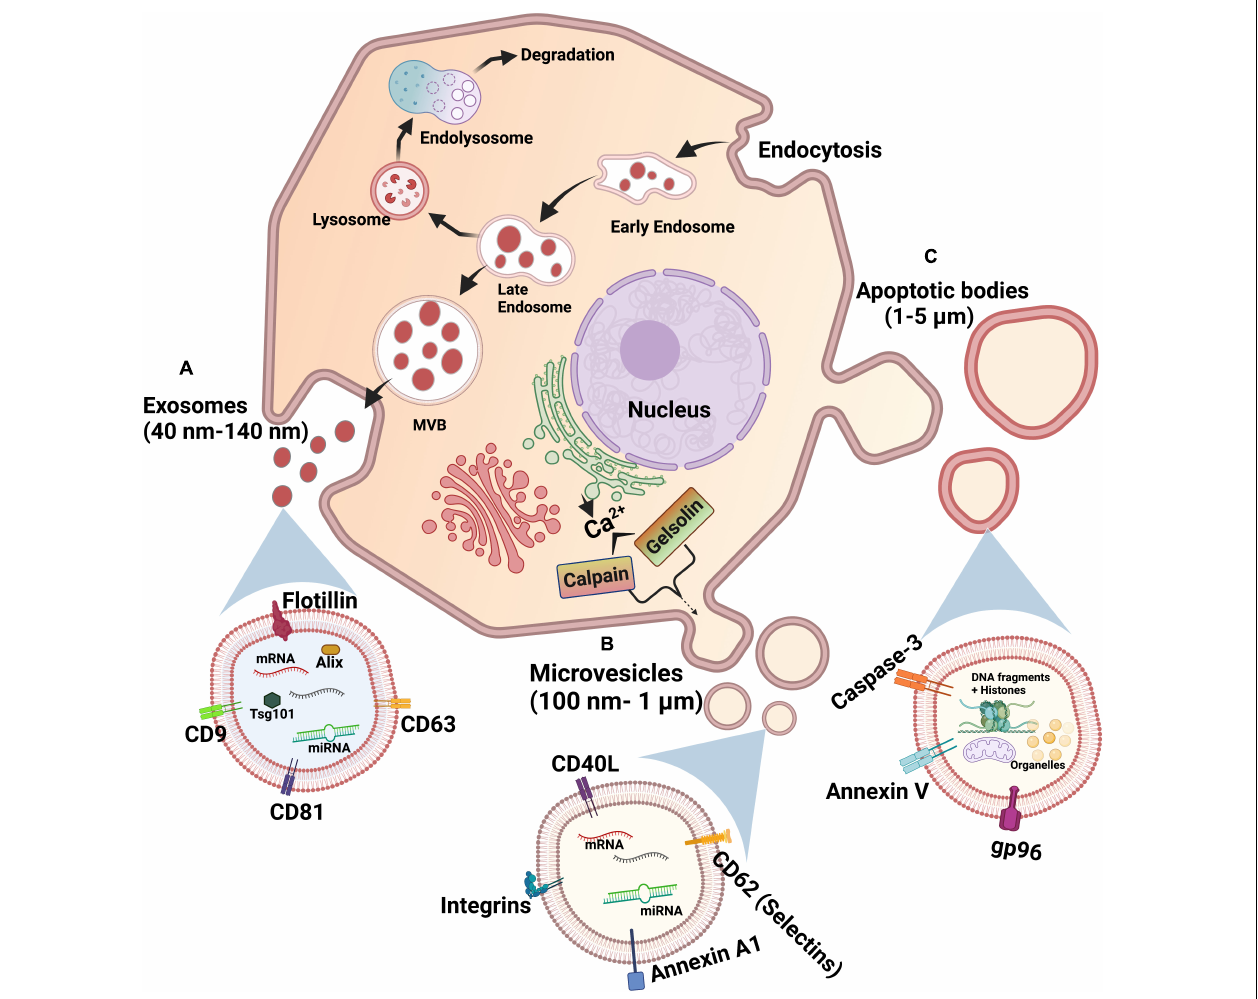
FIGURE 1 | Biogenesis of extracellular vesicles. (A) Exosomes: Starts with endocytosis-associated invagination of plasma membrane and forms an early endosome, late endosome, and sorted multivesicular body (MVB) by accumulating intraluminal vesicles, sequentially. MVB fuses with plasma membrane to release exosomes via exocytosis. (B) Microvesicles: Calcium ions released into the cytoplasm by endoplasmic reticulum cause the budding of microvesicles from plasma membrane via calpain- or gelsolin-mediated pathways. (C) Apoptotic bodies: An apoptotic cell undergoes sequential steps of large protrusions and blebbing of plasma membrane to release apoptotic